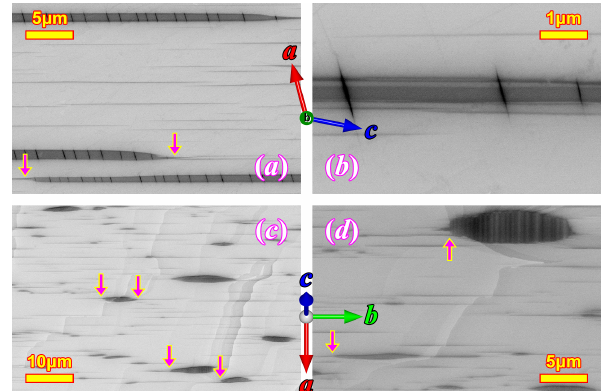
Figure 2. SEM images of the (010) section (a, b) and the (001) sec- tion (c, d) showing the feldspar exsolution lamellae in RLS. Much thinner films ( ∼ 100nm), which are responsible for the adulares- cence effect (Fig. 1b), can be observed in between the larger spin- dles. The arrows marks some of the thin films appearing as “tails” rooted in the larger spindles.